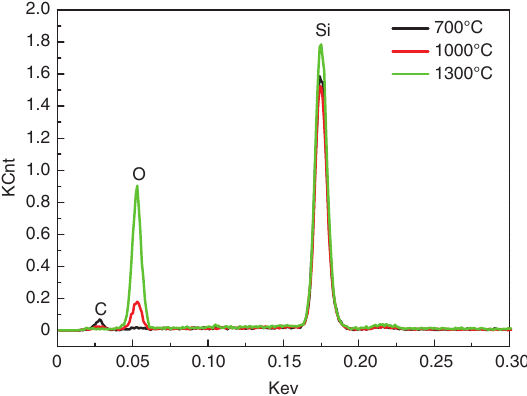
Figure 5 The morphology of the carbon fiber and PyC interphase after 10 h oxidized of samples A (A) and B (B) at 700 ° C.